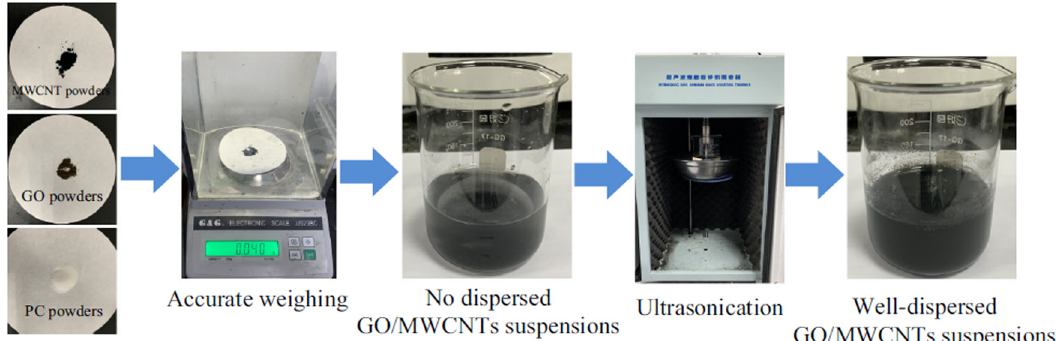
Figure 25: Preparation processes of dispersed GO/MWCNT suspensions [ 142 ]